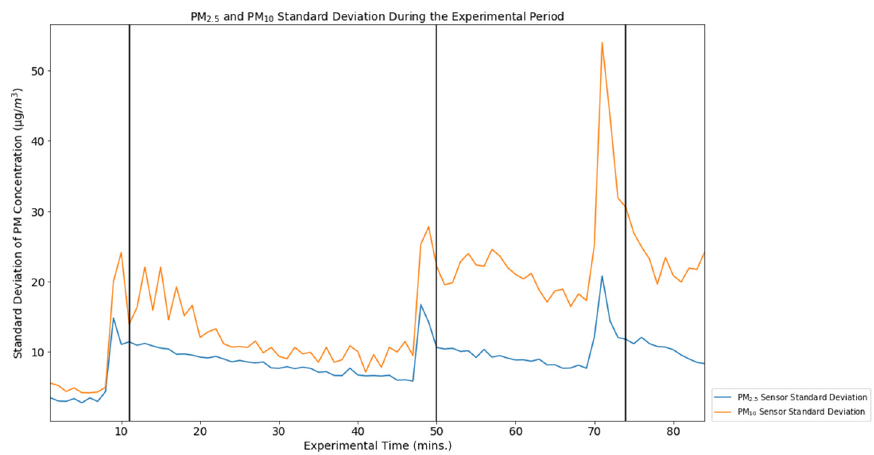
Figure 3. Flow PM 2.5 and PM 10 Average Standard Deviation During the Experimental Period. The average CV values for PM 10 and PM 2.5 measurements among the Flow devices were 0.52 and 0.76, respectively. When compared to the Plantower A003, the overall ac- curacy of the Flow device’s PM 10 measurements was − 380.59% and that of the PM 2.5 meas- urements was − 433.72%. In the five minutes after each incense introduction, accuracy of PM 2.5 measurements was higher, with averages of 21%, 47%, and 11% after incense intro- ductions, 1, 2, and 3, respectively. In the five minutes after each incense introduction, ac- curacy of PM 10 measurements was higher, with averages of 29%, 76%, and 21% after in- cense introductions, 1, 2, and 3, respectively. The overall RPE of each of the Flow devices’ measurements of PM 10 and PM 2.5 is presented in Table 1. Table 1. 31 comparisons were made among 32 sensors. Overall Precision